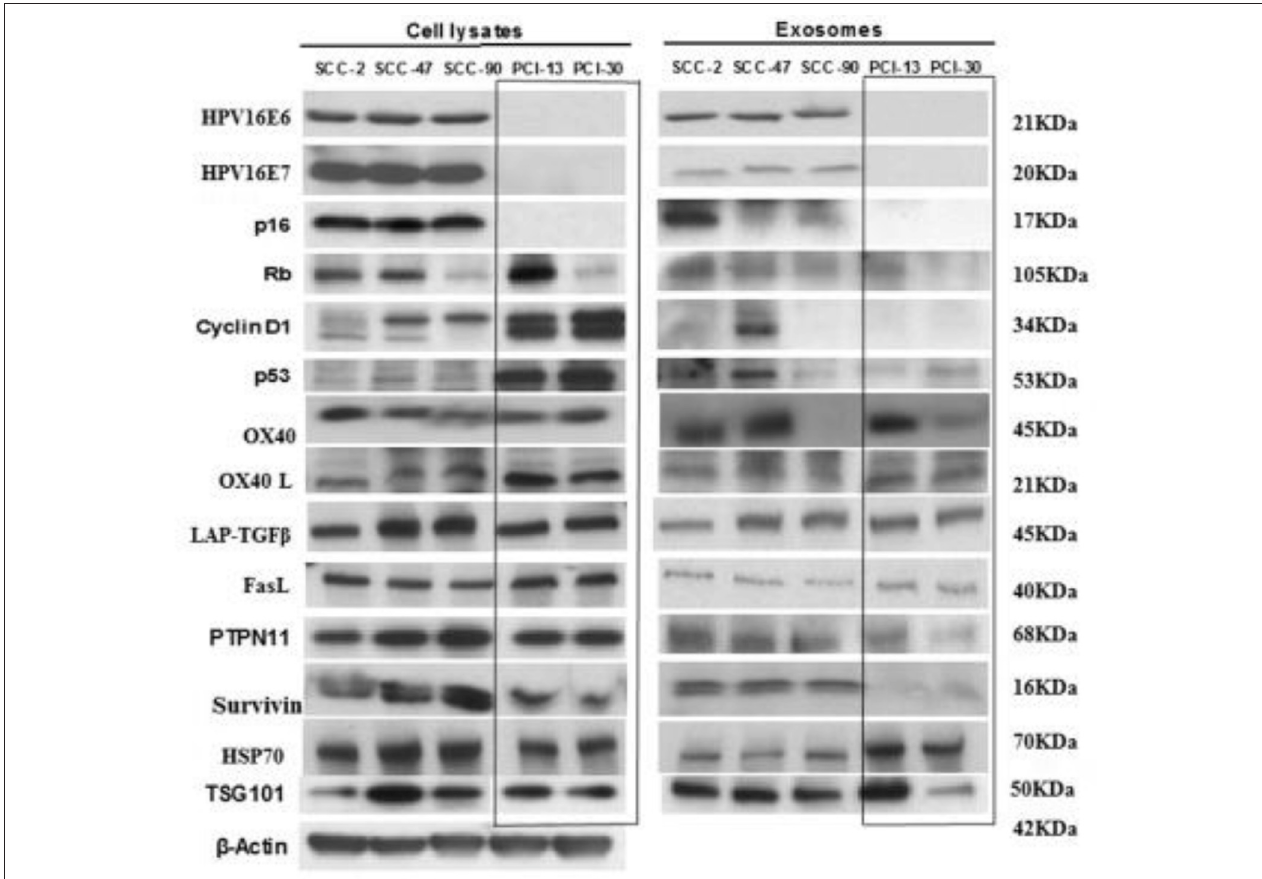
FIGURE 2 | Western blot (WB) profiles of cell lysates and of matching exosomes isolated from the supernatants of the HPV( + ) and HPV( − ) cell lines. Each lane was loaded with 10 µ g protein of the cell lysate or the corresponding exosome protein. The presence in exosomes of HPV-associated proteins (p16, Rb, Cyclin D1, p53) in HPV( + ) cell lysates and exosomes and their absence in HPV( − ) exosomes is evident. The blot images are grouped together, and the individual blots are shown in Supplementary Figure 2 . The box separates bands for HPV( − ) proteins, which are presented in opposite orientation from that shown in the original blots found in Supplementary Figure 2